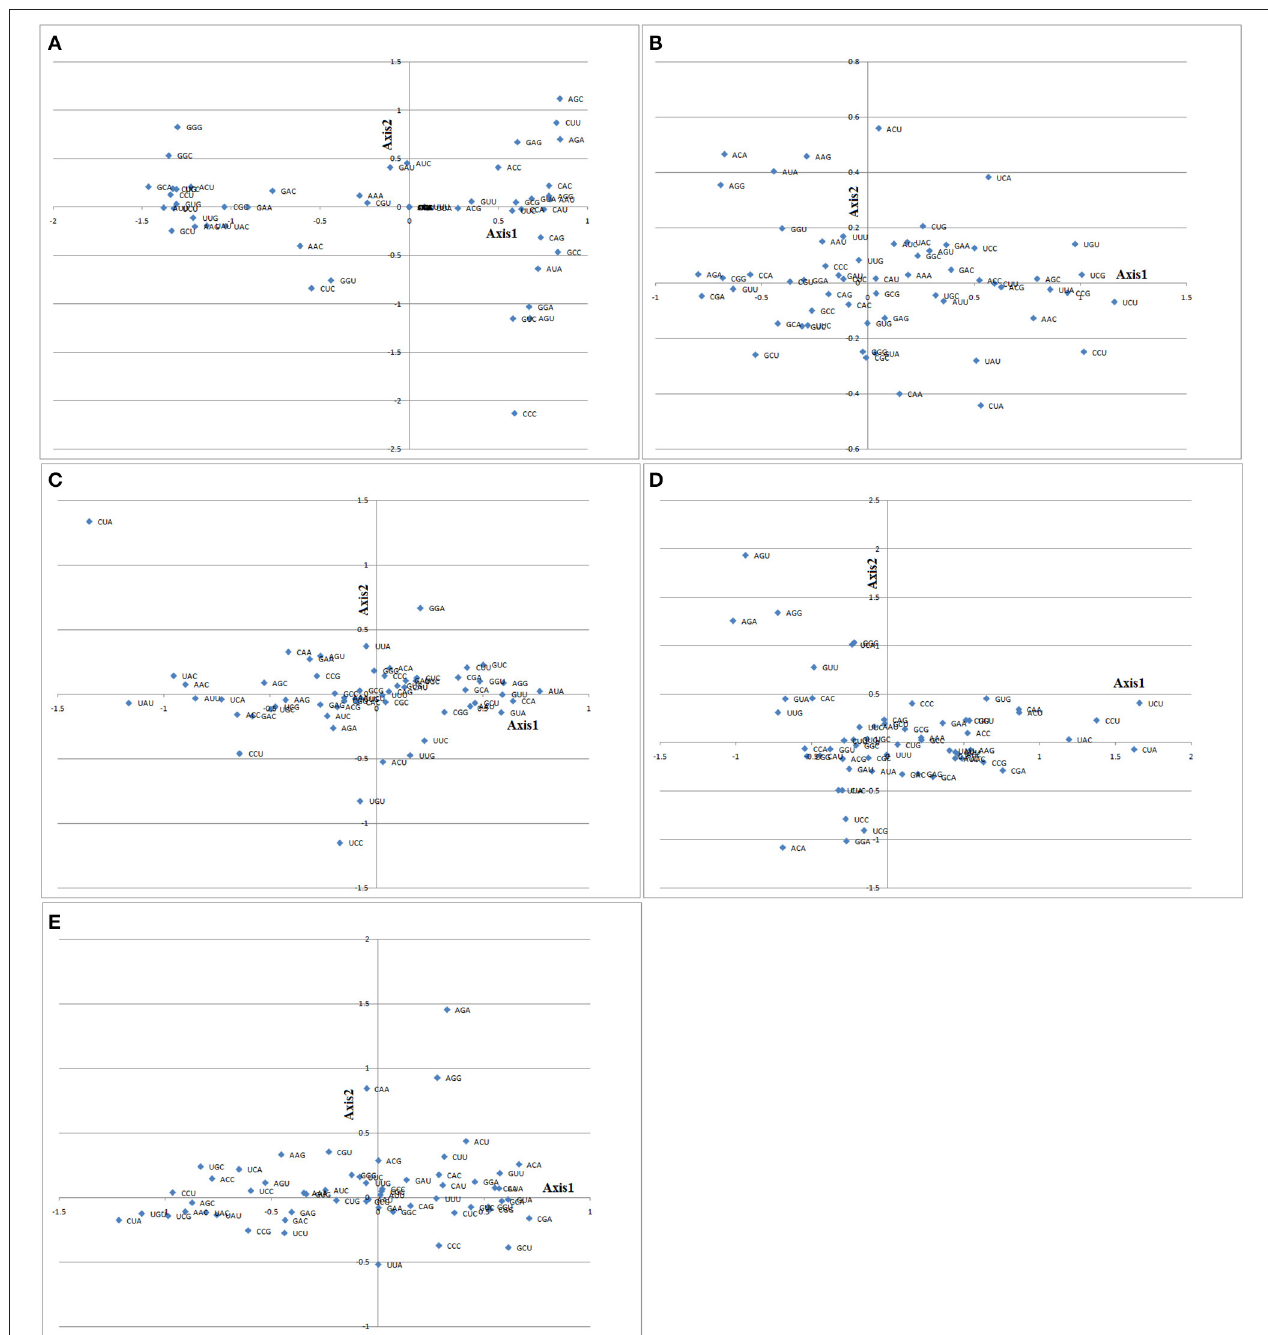
FIGURE 6 | The codon position along the first and second axes produced by correspondence analysis based on RSCU values of the 59 synonymous codons from pqqA (A) , pqqB (B) , pqqC (C) , pqqD (D) , and pqqE (E) genes from Cronobacter , Klebsiella , Kosakonia , Pantoea , Rahnella , and Serratia . x - and y -axis correspond to Axis 1 and Axis